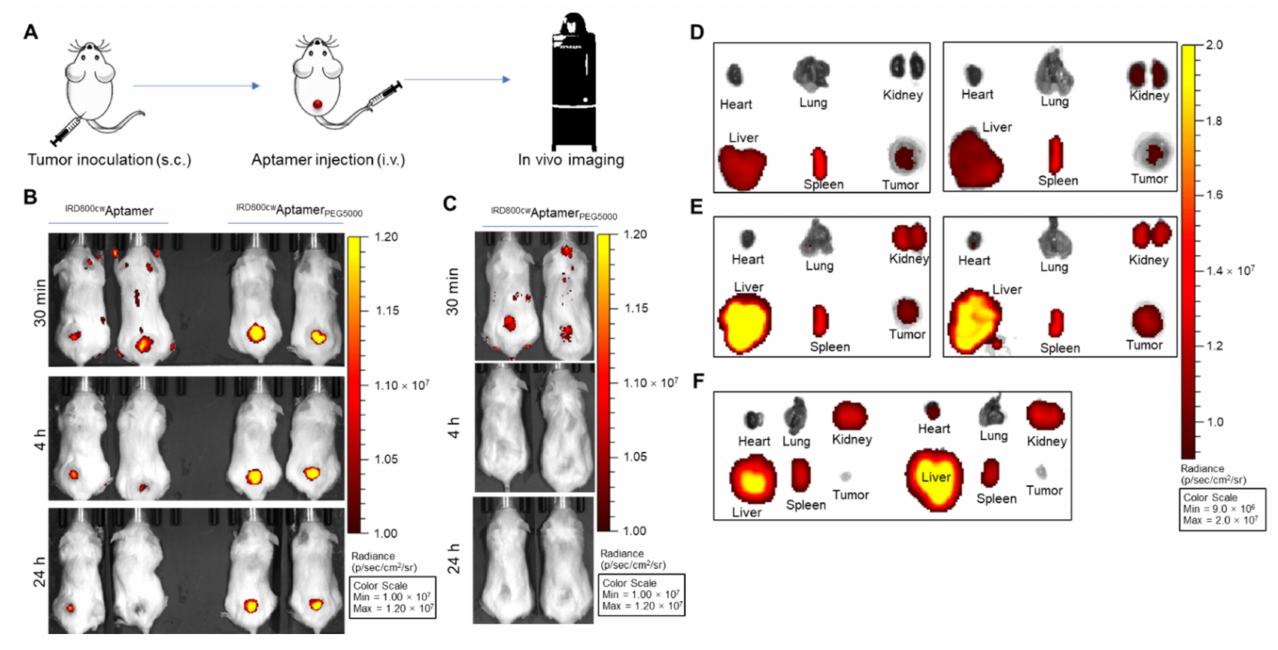
Figure 3. The IRD800CW PDGC21T PEG5000 aptamer specifically targets TNBC xenograft tumors and has an extended in vivo half-life. ( A ) Flow diagram of the in vivo tumor targeting study using aptamer probes. The red sphere indicates the xenograft tumor site. s.c., subcutaneous; i.v., intravenous. ( B ) Relative to IRD800CW PDGC21T aptamers, the signal enhancement from IRD800CW PDGC21T PEG5000 aptamers was stronger and persisted longer in MDA-MB-231 tumors (up to 24 h post-aptamer admin- istration). ( C ) In contrast, weak signals were observed peripherally in MCF7 tumor sites at 30 min post IRD800CW PDGC21T PEG5000 aptamer administration but faded rapidly and became undetectable under the same imaging conditions. ( D , E ) Ex vivo imaging of resected MDA-MB-231 xenograft tumors, hearts, lungs, kidneys, livers, and spleens from mice treated with IRD800CW PDGC21T aptamers ( D ), or IRD800CW PDGC21T PEG5000 aptamers ( E ) post-whole-body imaging. ( F ) Ex